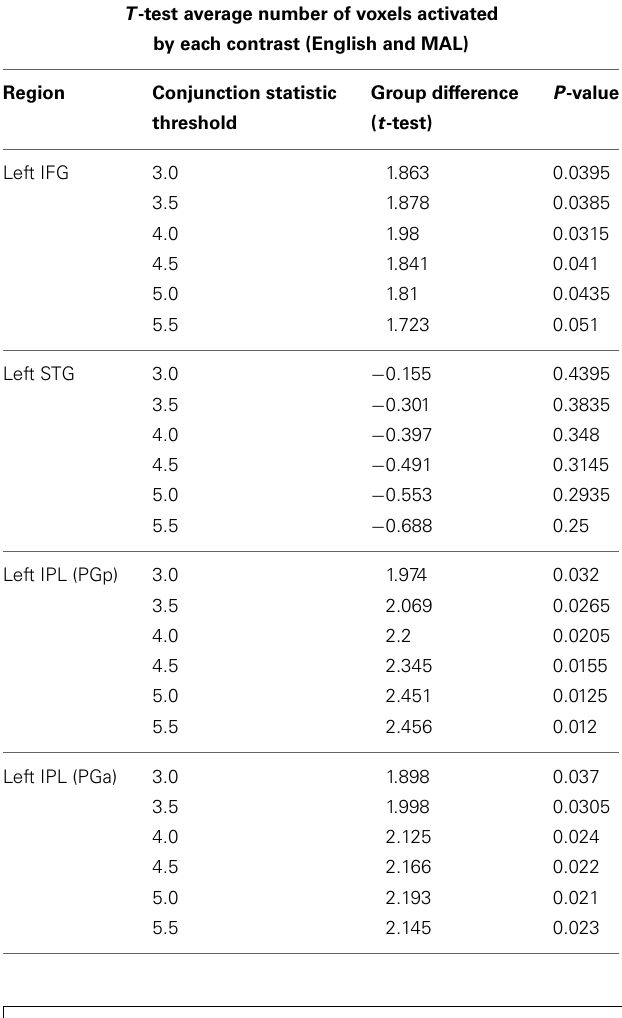
Table 6 | Conjunction group differences. T -test average number of voxels activated